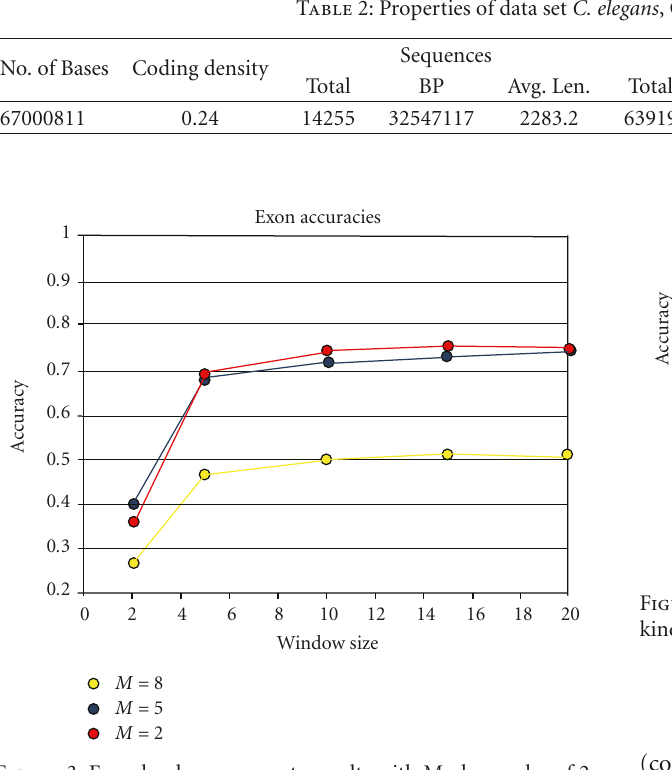
Figure 3: Exon level accuracy rate results with Markov order of 2, 5, and 8, respectively, for C. elegans , Chromosomes I–V.